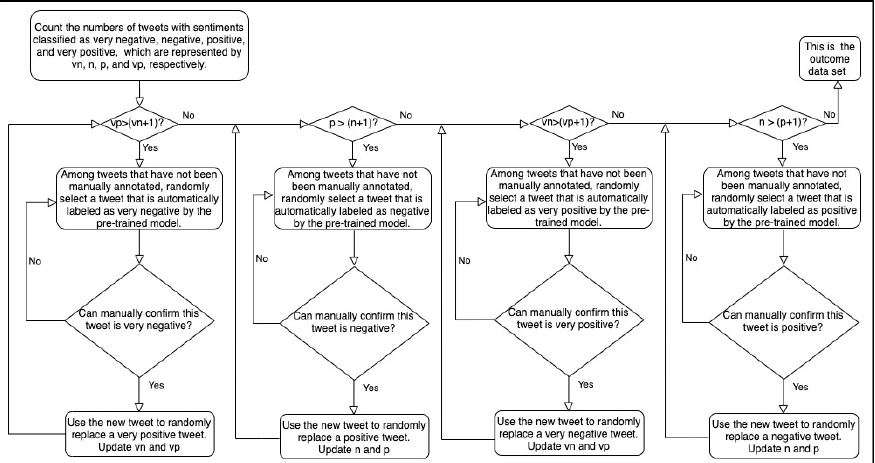
Figure 2. Brief pipeline of the preprocessing method with the complete mode. The complete mode requires the difference between the number of very negative samples and the number of very positive samples to be no more than one. This mode also requires the difference between the number of negative samples and the number of positive samples to be no more than one. Therefore, the resulting data set of the complete mode is completely balanced. Table 3. The numbers of tweets in the five sentiment categories in each data set.